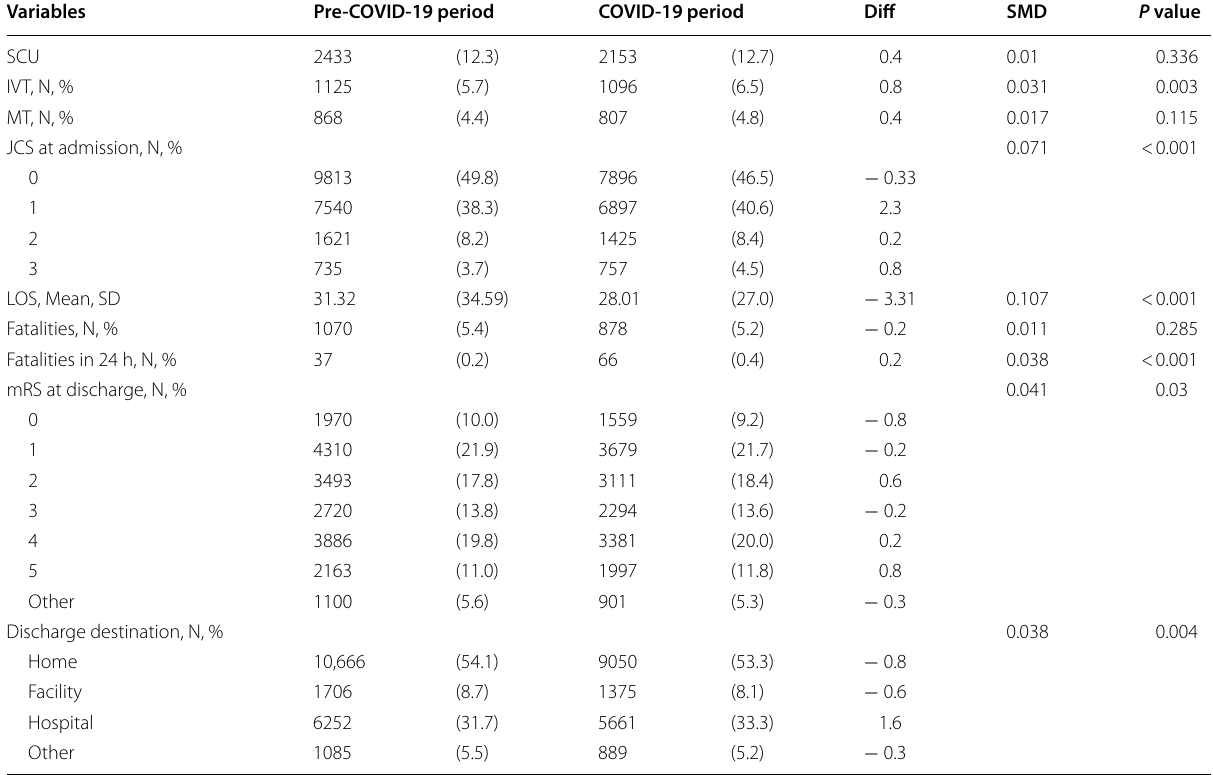
SCU Stroke care unit, IVT intravenous thrombolysis, MT Mechanical thrombectomy, LOS length of hospital stay, JCS Japan Coma Scale, mRS modified Ranking